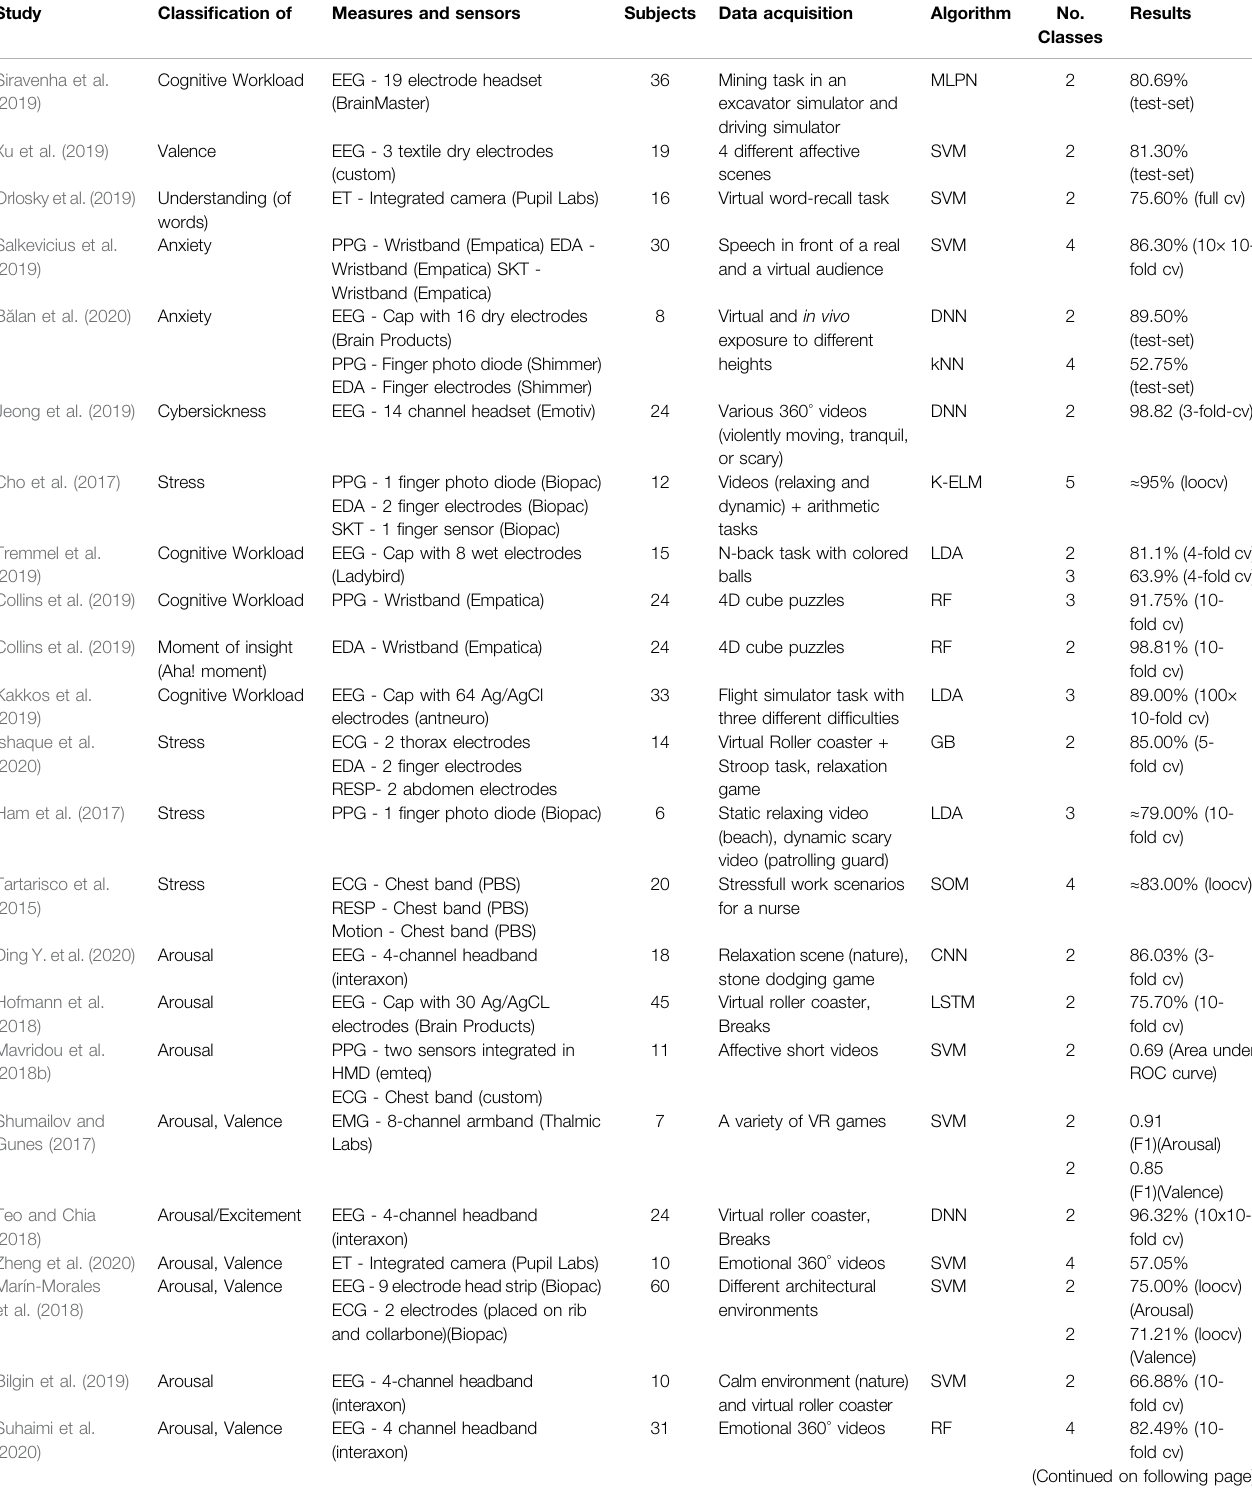
TABLE 2 | Overview of classi fi cation approaches based on physiological data collected in full-immersive VR. If not stated otherwise, the values presented in the Results columnusuallyrefertotheaccuracythatwasachievedinacrossvalidationoronanextratest-set.Thesevaluesserveonlyasaroughguidetothesuccessofthemethod and are not comparable